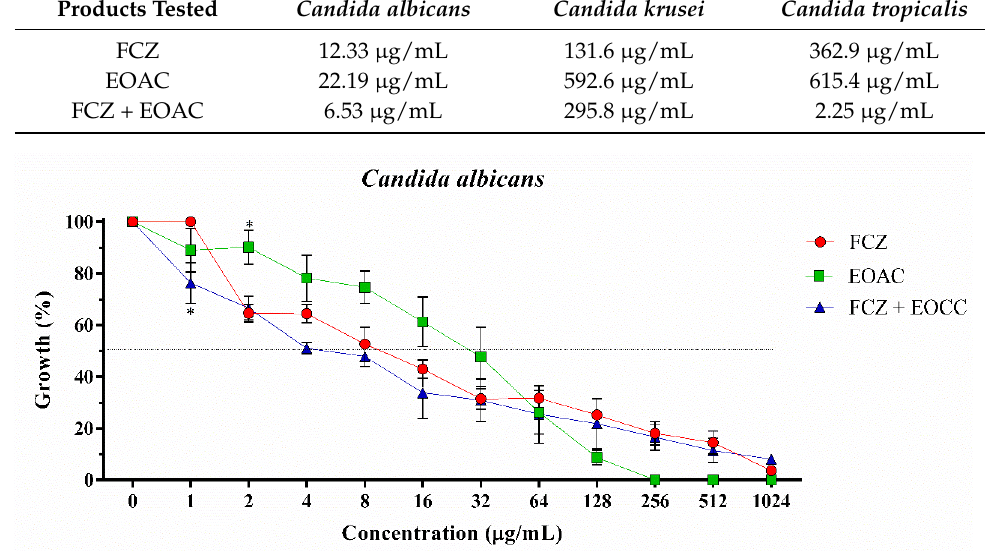
Figure 1. Cell viability curve of Candida albicans INCQS 90028 against essential oil of Acritopappus confertus (EOAC) and fluconazole (FCZ) in μg/mL. Statistically significant value with * p < 0.05.